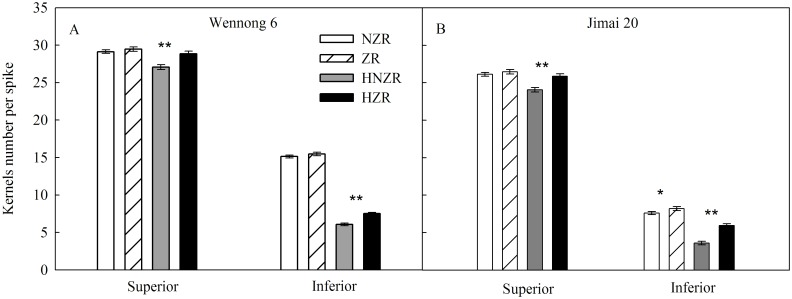
Effects of high temperature and exogenous ZR on the kernel number at 10 days after anthesis.NZR and ZR represent detached spike culture without and with ZR under 25/20°C condition, respectively. HNZR and HZR represent detached spike culture without and with ZR under 35/20°C condition, respectively. Vertical bars represent ± standard error of the mean (n = 9) where they exceed the size of the symbol. *, ** denote significant differences at P < 0.05, P < 0.01, respectively.